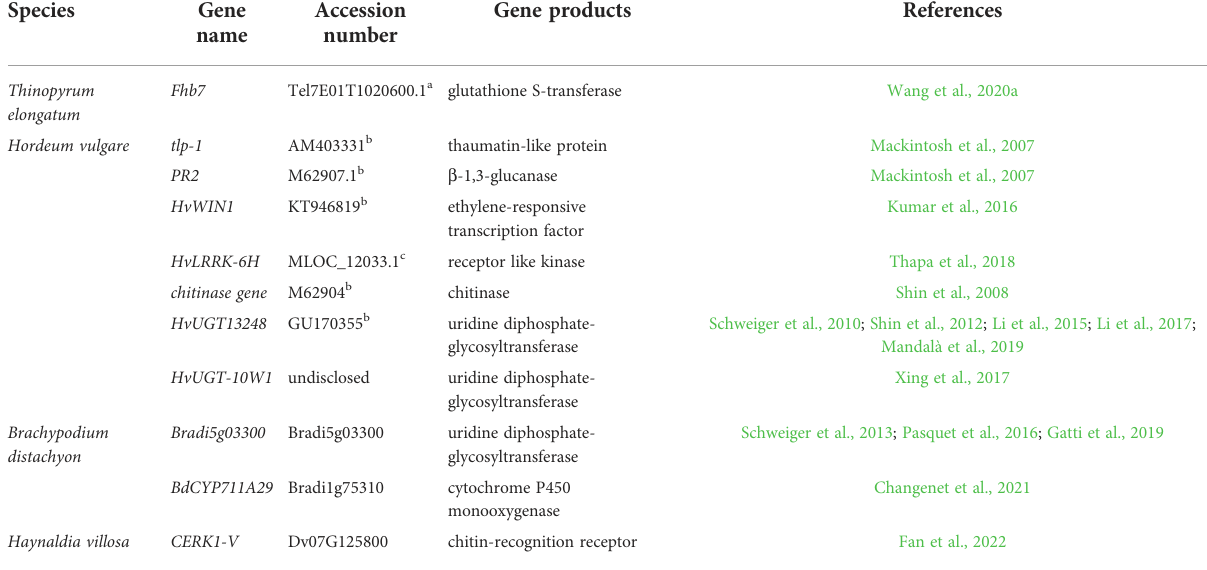
TABLE 2 Genes identi fi ed with FHB resistance in wheat